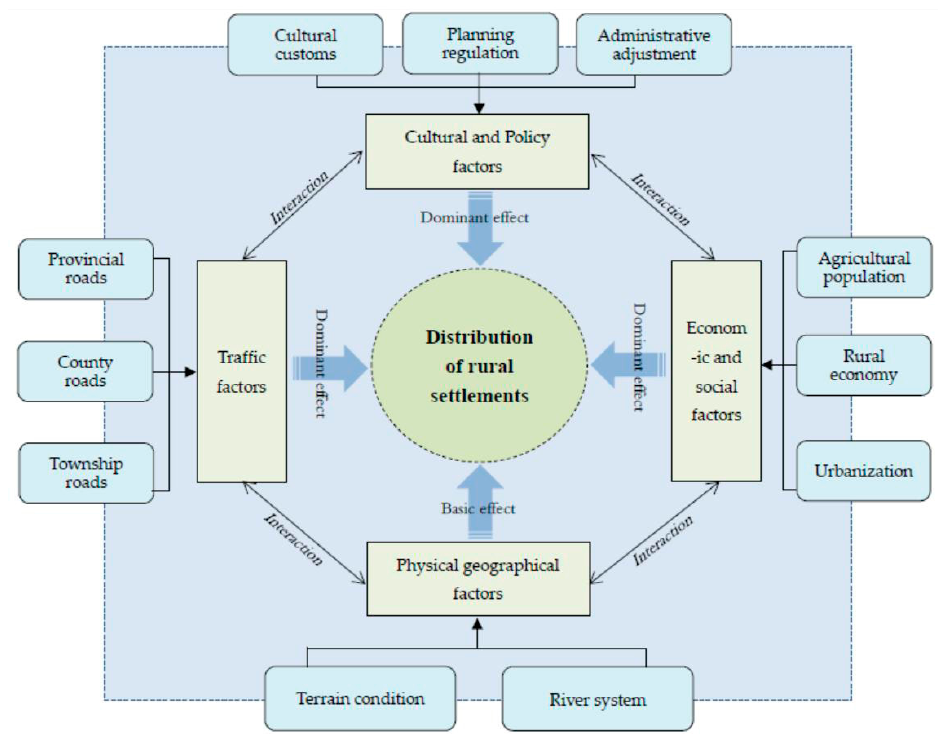
Figure 9. Impact mechanism of rural settlement distribution in the metropolitan fringe area.